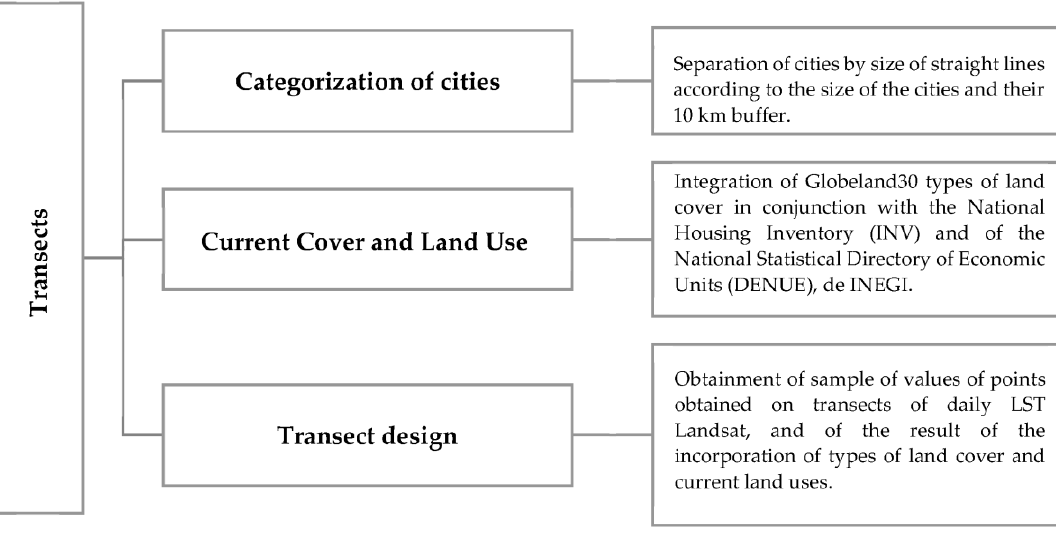
Figure 3. Methodology for Defining Transects.